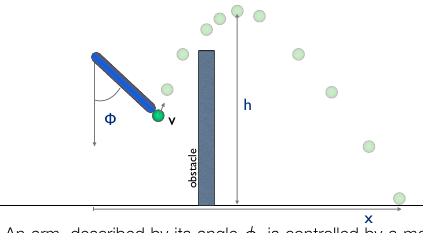
Figure 1. An arm, described by its angle